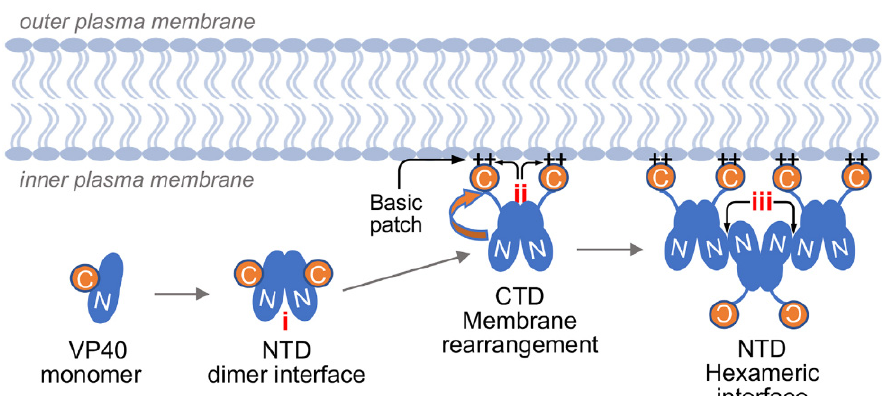
Figure 1. This cartoon schematic illustrates EBOV VP40–VP40 interaction phases crucial for viral particle formation: (i) VP40 NTD homodimers are formed. Once at the plasma membrane, VP40 rearrangement occurs through (ii) a basic patch containing six lysine residues. This rearrangement triggers exposure of (iii) an NTD surface that interacts at the hexameric interface between VP40 molecules necessary to form the viral matrix.